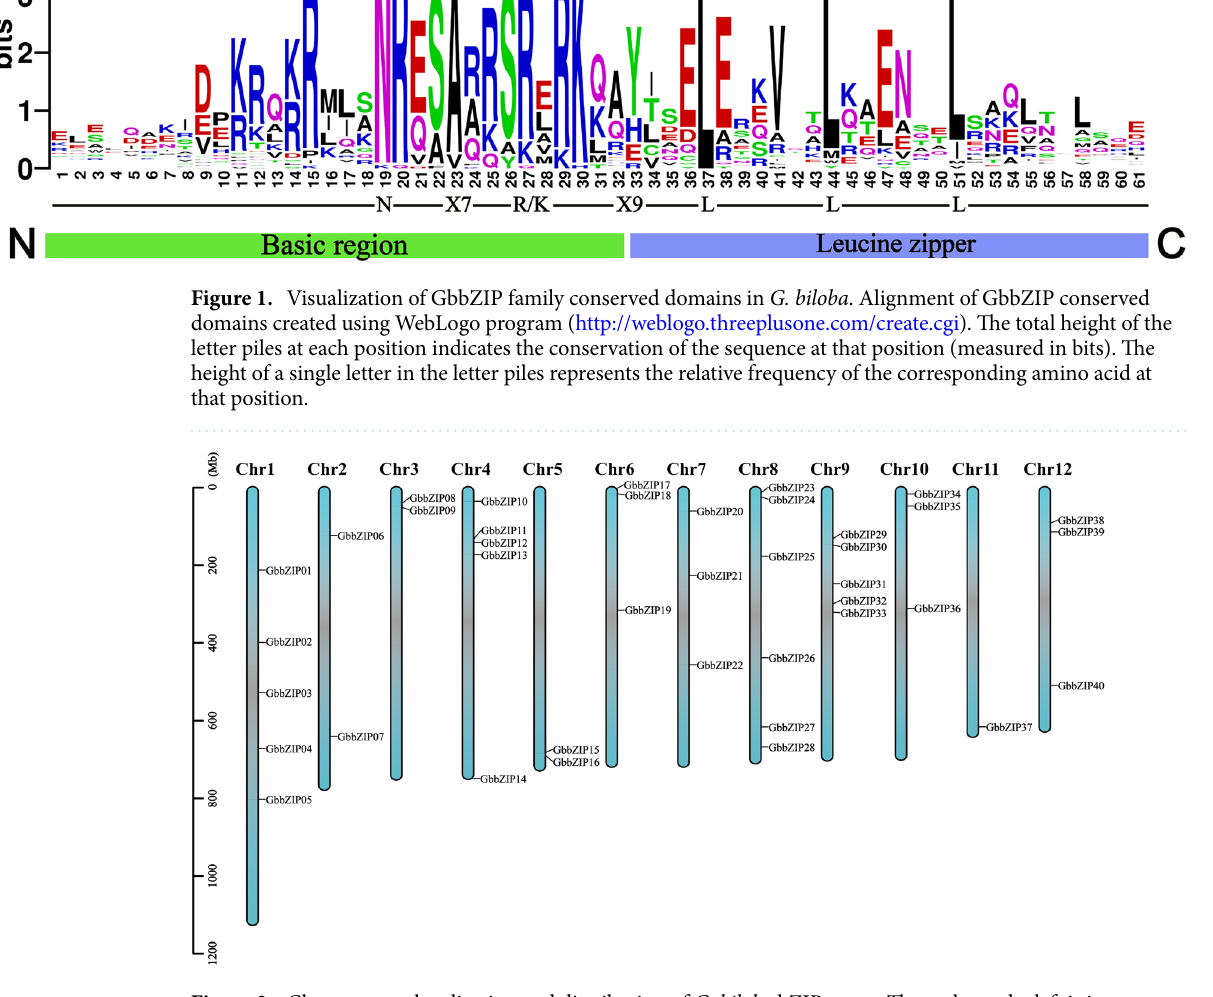
Figure 2. Chromosome localization and distribution of G. biloba bZIP genes. The scale on the left is in megabases